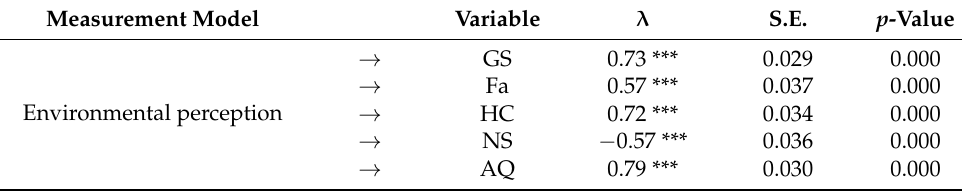
Table 7. Estimate result of